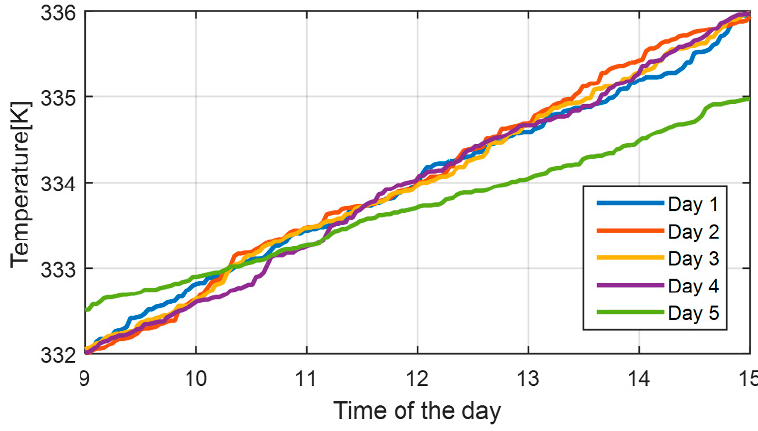
Figure 9. Hot plate temperature during the day.